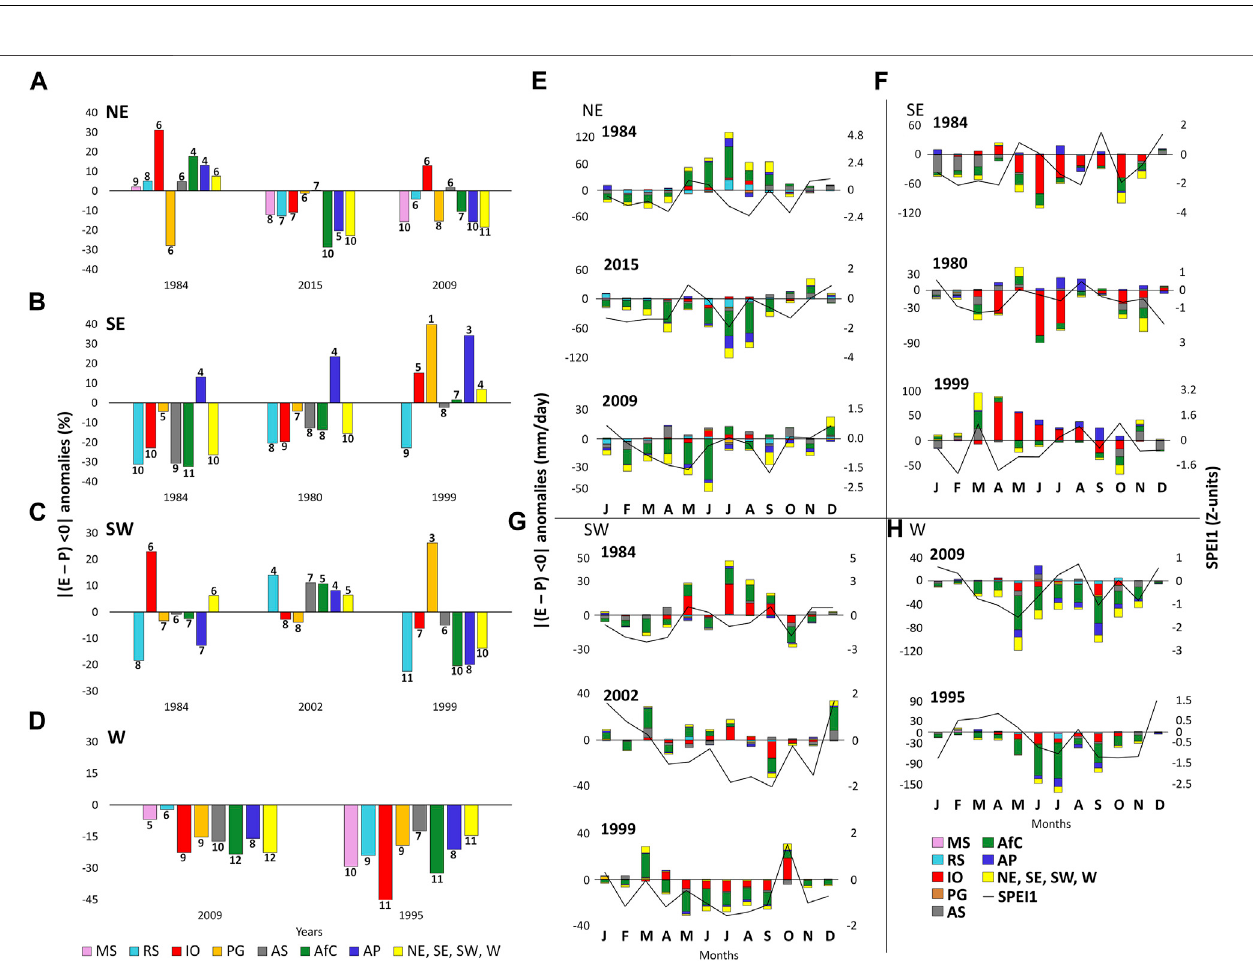
FIGURE 9 | Leftpanel:Anomaliesonthemoisture contributiontoprecipitation|(E − P) < 0|(expressedinpercentage)fromevery sourceduringyearsaffectedbysevereor extremedroughtconditionsinthestudyregions; NE (A) , SE (B) , SW (C) ,and W (D) ; and thenumber ofmonthswithanegativeanomaly onthemoisturecontributionfrom each source (expressed in numbers). Right panels: SPEI1 and monthly anomalies of |(E − P) < 0| during each year in the study regions; NE (E) , SE (F) , SW (G) , and W (H) .